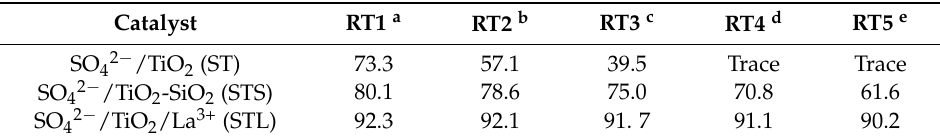
Table 7. FAMEs yield (%) with various catalyst reused times over catalysts.